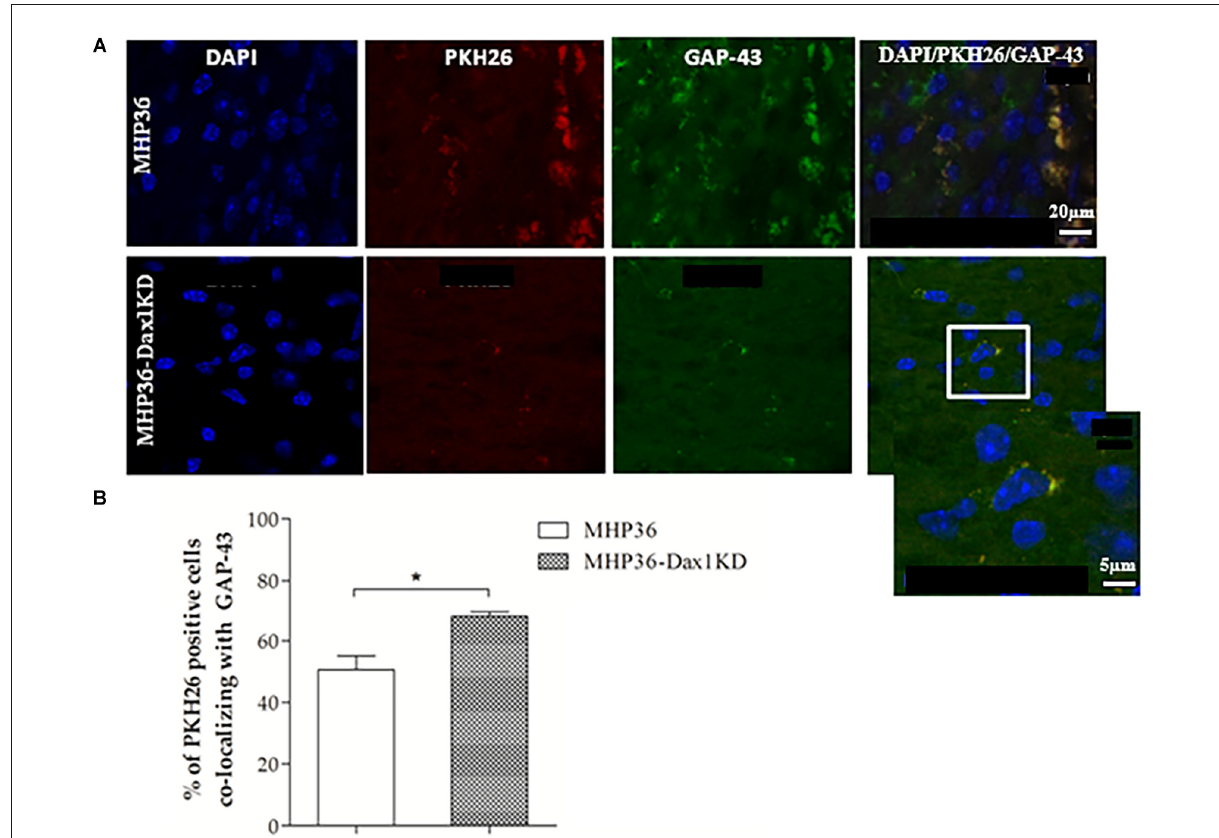
FIGURE6 MHP36-Dax1KD grafts increased expression of GAP-43 in the host brain. (A) MHP36-Dax1KD and MHP36 grafts expressed the marker for synaptic plasticity GAP-43 (scale bar = 20 µ m, Bregma: -0.3 ± 0.10 mm) and at higher magnification, PKH26 labeled MHP36-Dax1KD co-localizing with GAP-43 (white inset; scale bar = 5 µ m). (B) Percentage of PKH26-labeled cells co-localizing with GAP-43 in the cortex at 28 days post-MCAO in animals grafted with MHP36 and MHP36-Dax1KD (* p < 0.05; n = 3 all